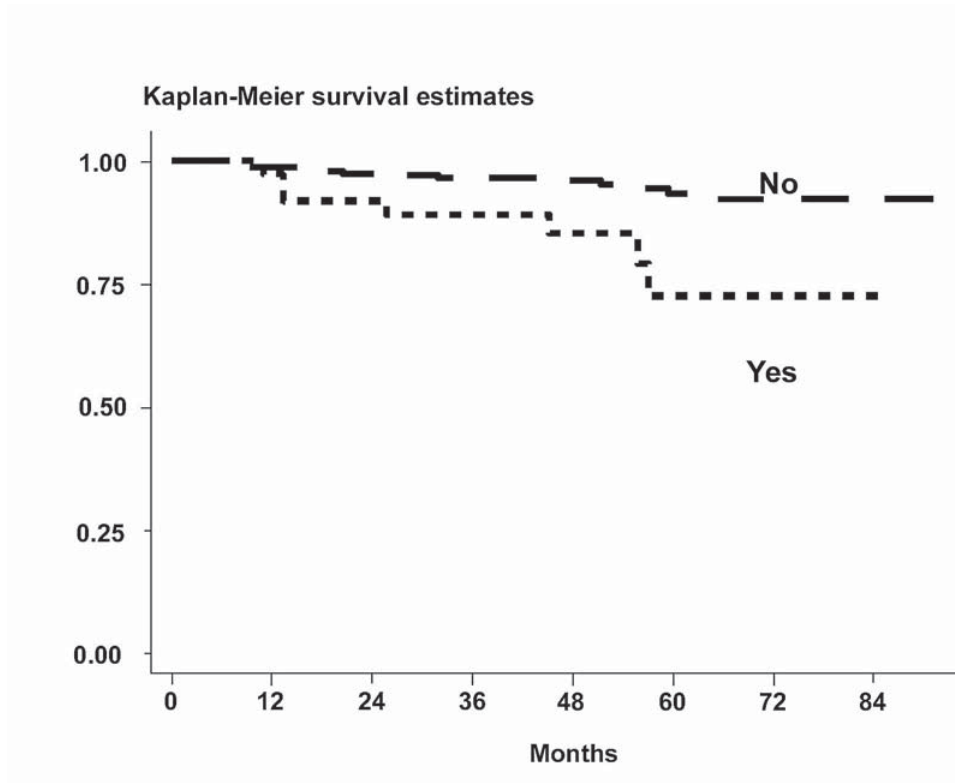
Figure 1 – Actuarial free from late urinary toxicity grade 2-3 survival according to prior transurethral